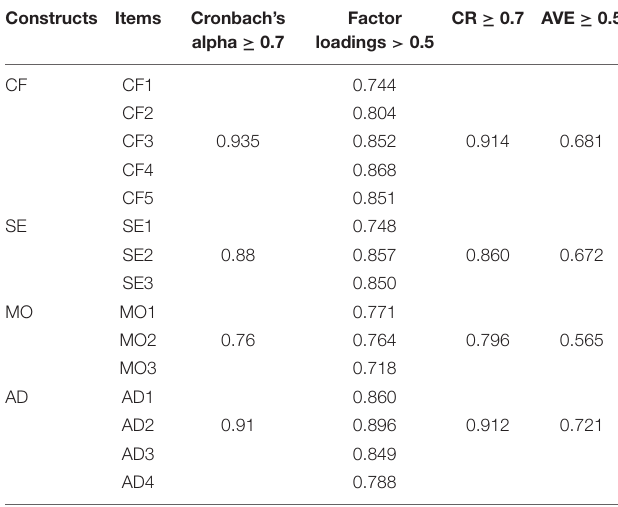
TABLE 3 | Construct reliability, factor loadings, composite reliability, and average variance extracted. Constructs Items